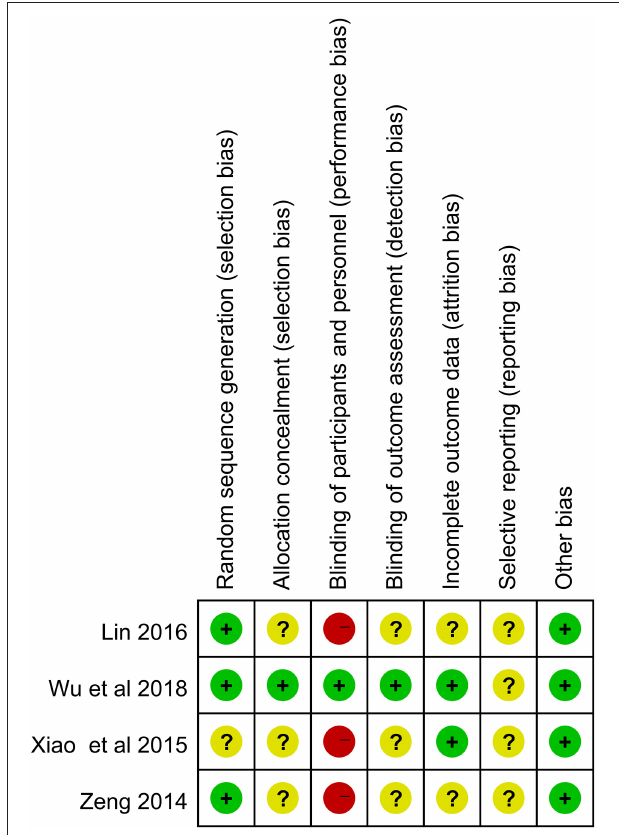
FIGURE 3 | Risk of bias summary.